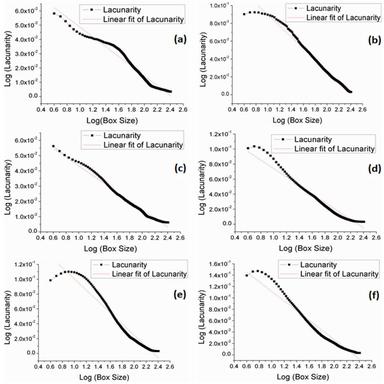
The graphical representation of the lacunarity of samples: a) BF1, b) BF2, c) BF3, d) B4, e) BF5 and, f) BF6. The black curve and the straight line represent the lacunarity and linear fit of lacunarity, respectively.